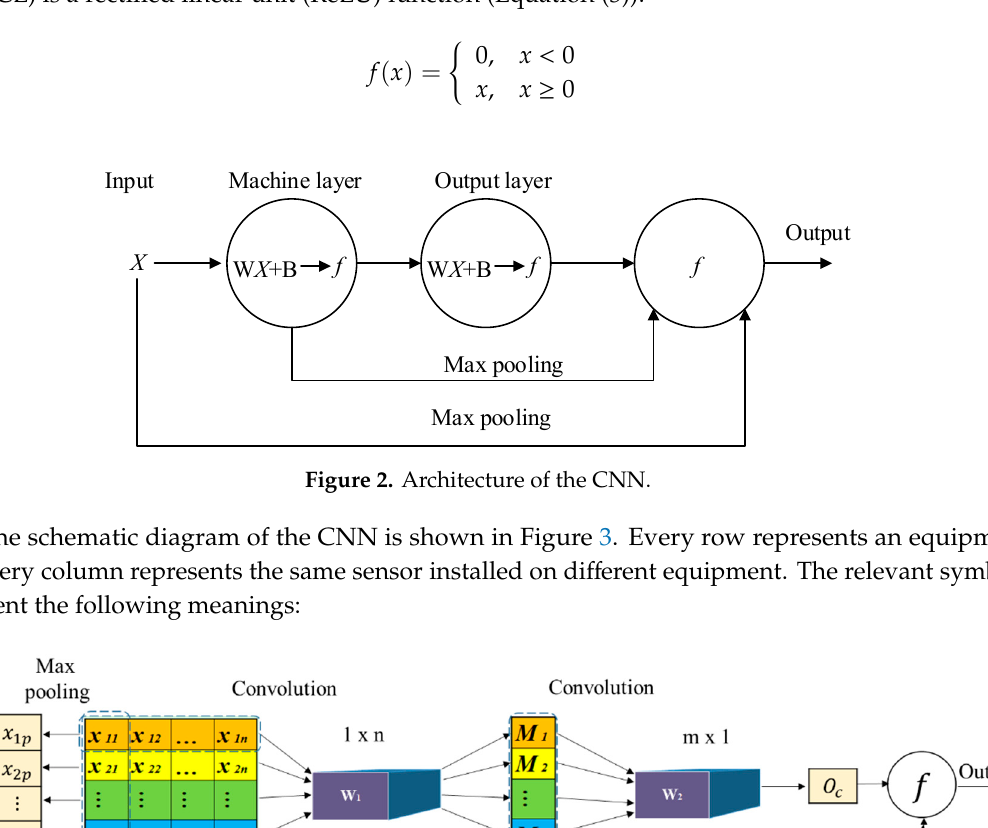
Figure 2. Architecture of the CNN.